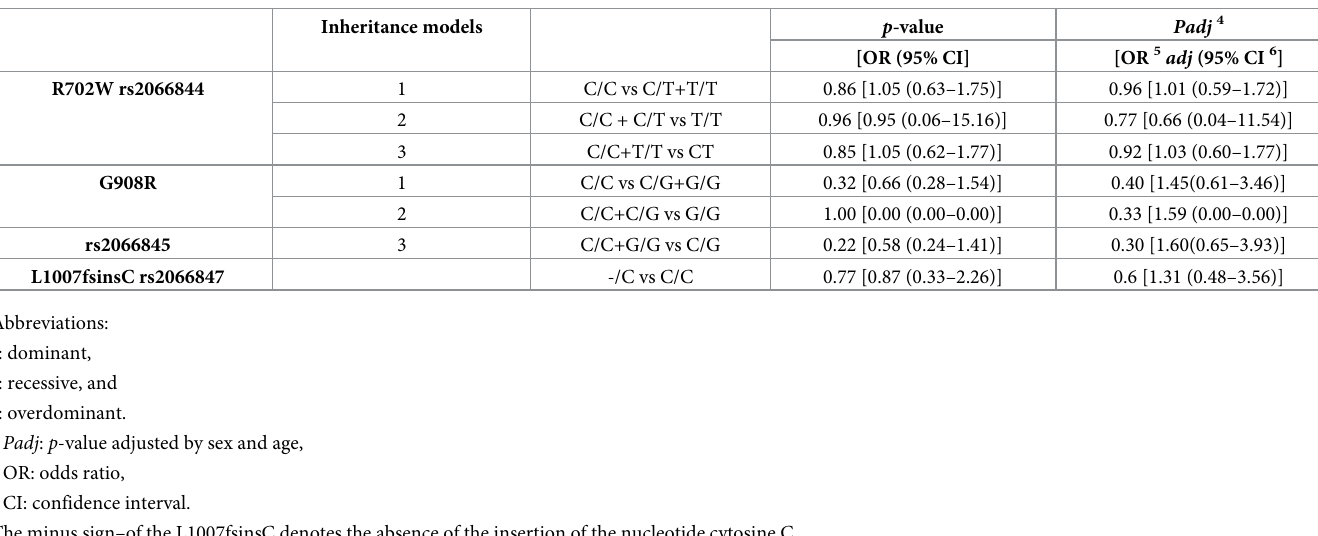
None of the participants had more than one of the three variants. The minor alleles of the three variants (R702W, G908R, and L1007fsinsC) termed allele O and wild-type alleles as A were statistically compared between the patients with Lg -CL and HC (Table 4). Heterozygotes A/O frequency was 6.3% and 5.6% among the healthy controls and patients with Lg -CL, respectively. The frequency of the minor allele O was 3.3% among the HC and 3.1% in the patients with Lg -CL. Comparisons of genotype or allele frequencies between patients with Lg - CL and healthy controls did not reveal any association. The minor alleles were not associated with either susceptibility or protection to Lg -CL.